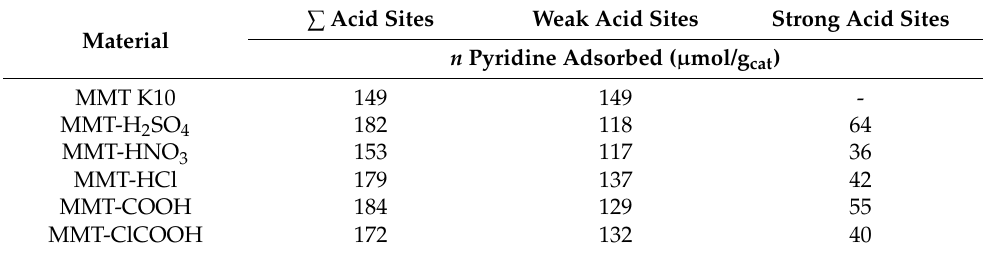
Table 3. Adsorbed amount of pyridine (results from temperature programmed